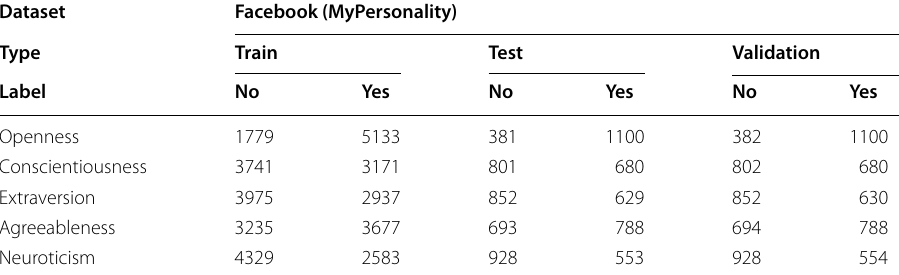
Table 2 Facebook Dataset Distribution